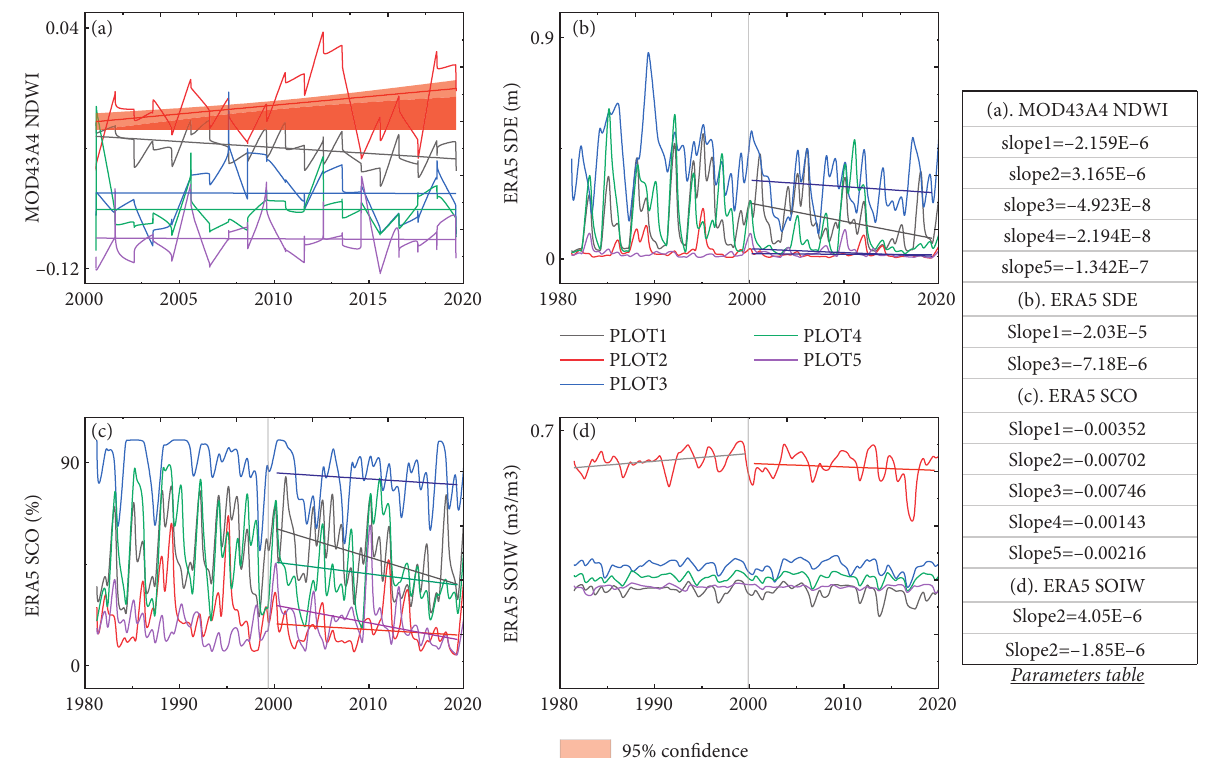
Figure 12: Hydrology change trend of the swamp wetland on a plot scale. (a), (b), (c), and (d) are the change trends of MOD43A4